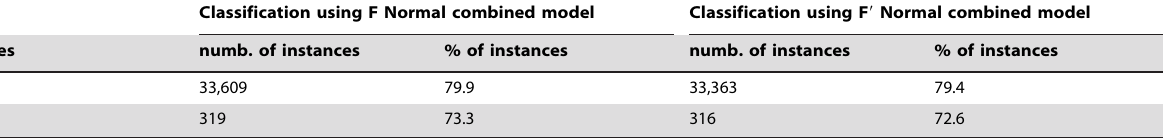
Table 2. Summary of the number of instances of the test set correctly classified using the F and F 9 Normal combined models.